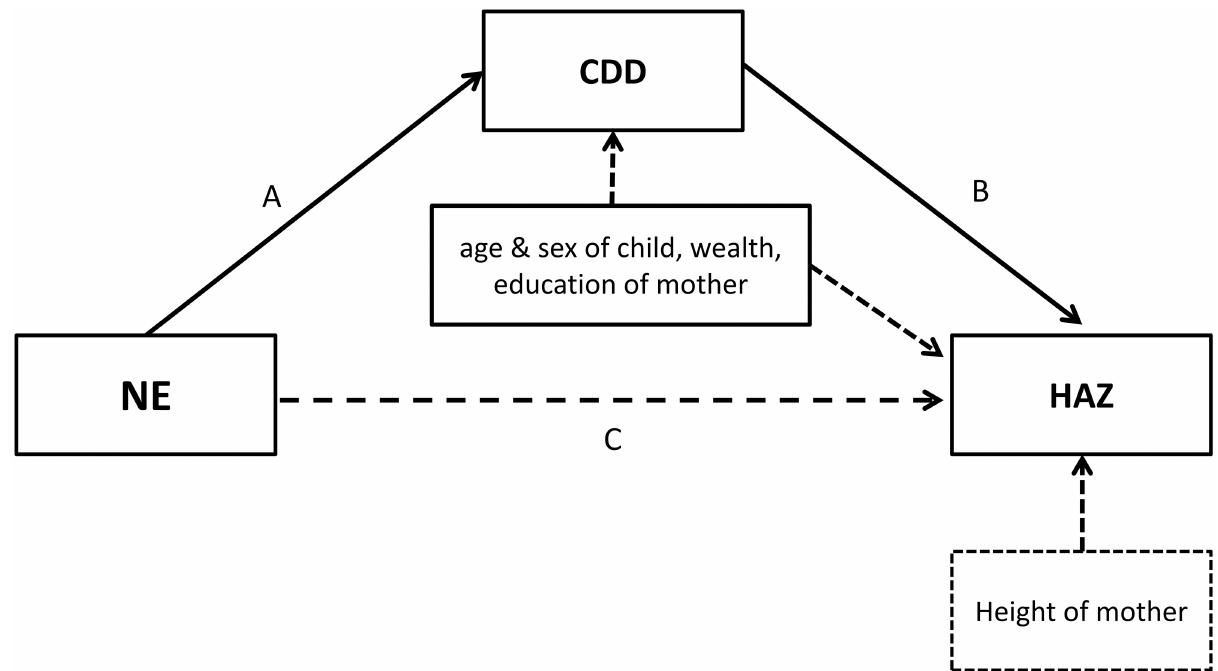
Fig 2. Indirect effectsof nutrition education on HAZ. PathwayA: NE (the independentvariable)impact on CDD (the mediator) controlled for age and sex of the child, wealth status of the household and educational status of the mother. Pathway B: HAZ (the dependentvariable) influenced by CDD (the mediator) controlled for age and sex of the child, wealth status of the household,educational status and height of the mother. Pathway C: the model does not considera direct effect of NE on HAZ.